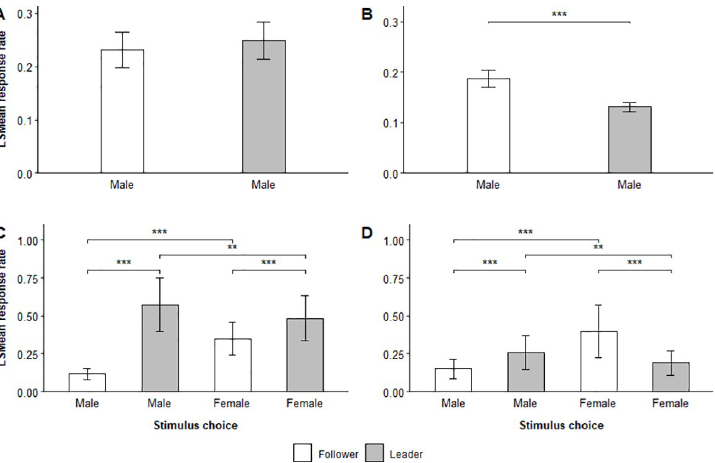
Fig 3. Effect of vocal role and sex on response rate. LSMean ( ± SE) contact call response rate emitted by focal flocks during the (A) interaction and (B) choice phase of male-male trials where flocks chose the follower or leader, and during the (C) interaction and (D) choice phase of male-female trials where flocks chose a male or female follower or leader. Significant selected pairwise comparisons are indicated with asterisks.